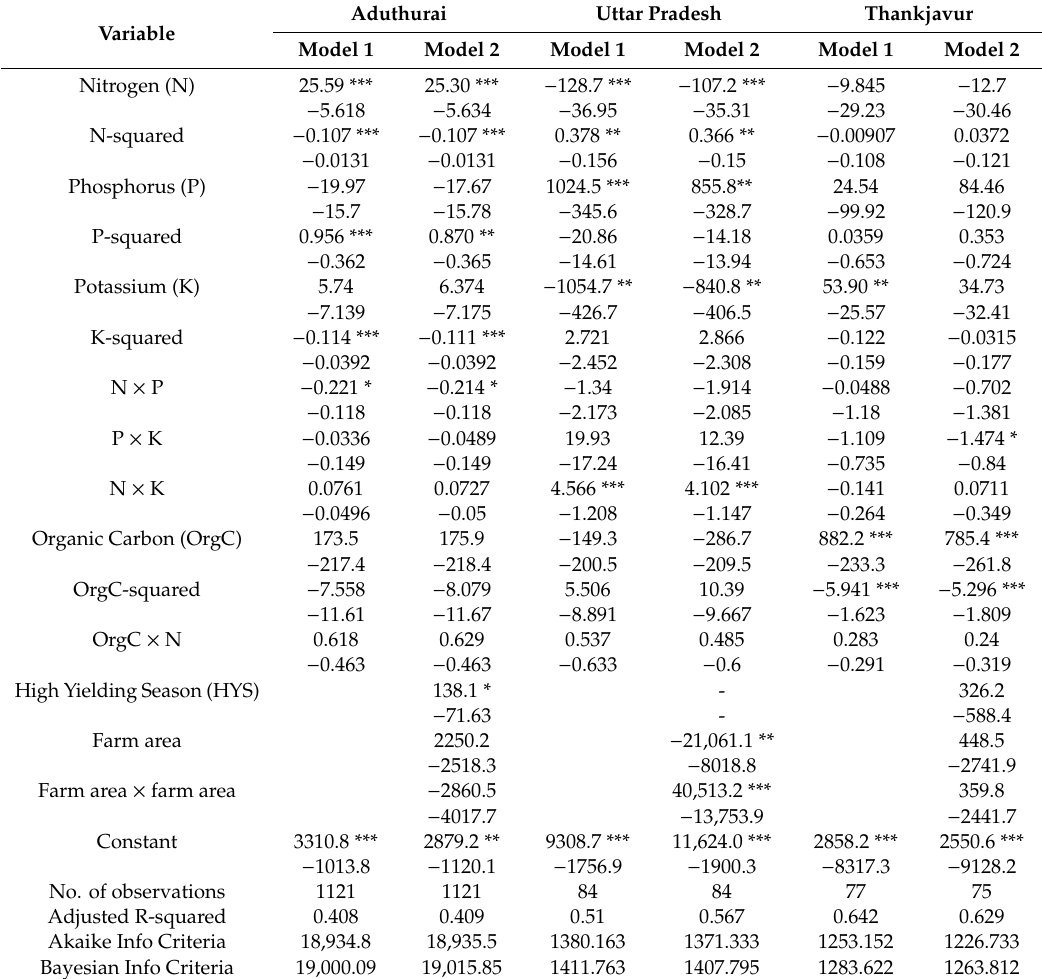
Table 4. Production function estimates using two versions of the quadratic model in